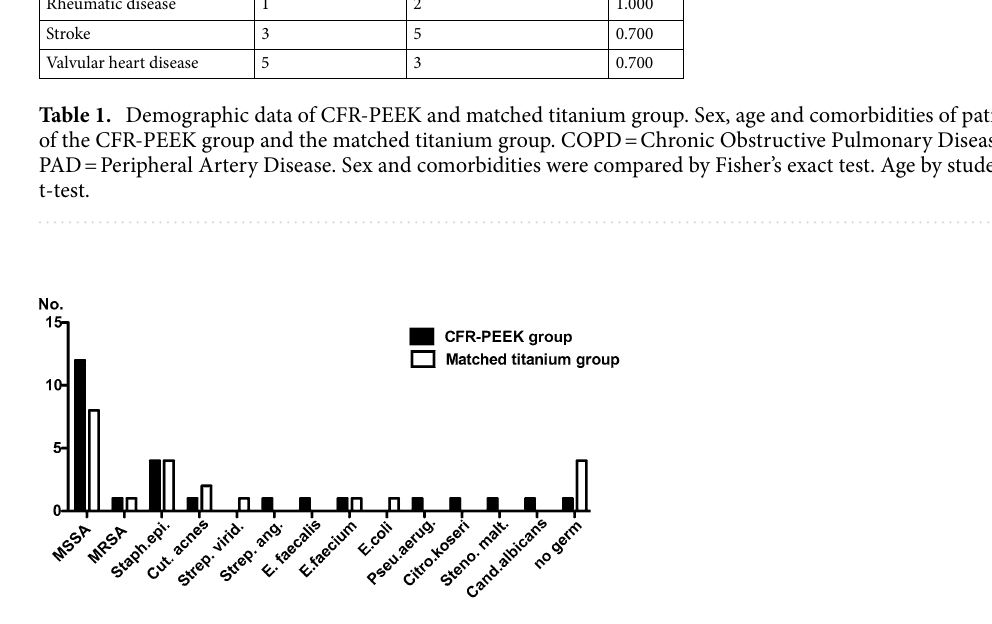
Figure 1. Bacterial spectrum of CFR-PEEK group and matched titanium group. Spectrum of germs causing spondylodiscitis in the CFR-PEEK group and matched titanium group. y-axis designating the number how often a germ was detected. Cand. albicans = Candida albicans ; Citro. koseri = Citrobacter koseri ; Cut. acnes = Cutibacterium acnes ; E. coli = Eschericha coli ; E. faecalis = Enterococcus faecalis ; E. faecium = Enterococcus faecium ; MRSA = methicillin resistant Staphylococcus aureus ; MSSA = methicillin sensible Staphylococcus aureus ; Staph. epi. = Staphylococcus epidermidis ; Steno. malt. = S tenotrophomonas maltophilia ; Strep. ang. =